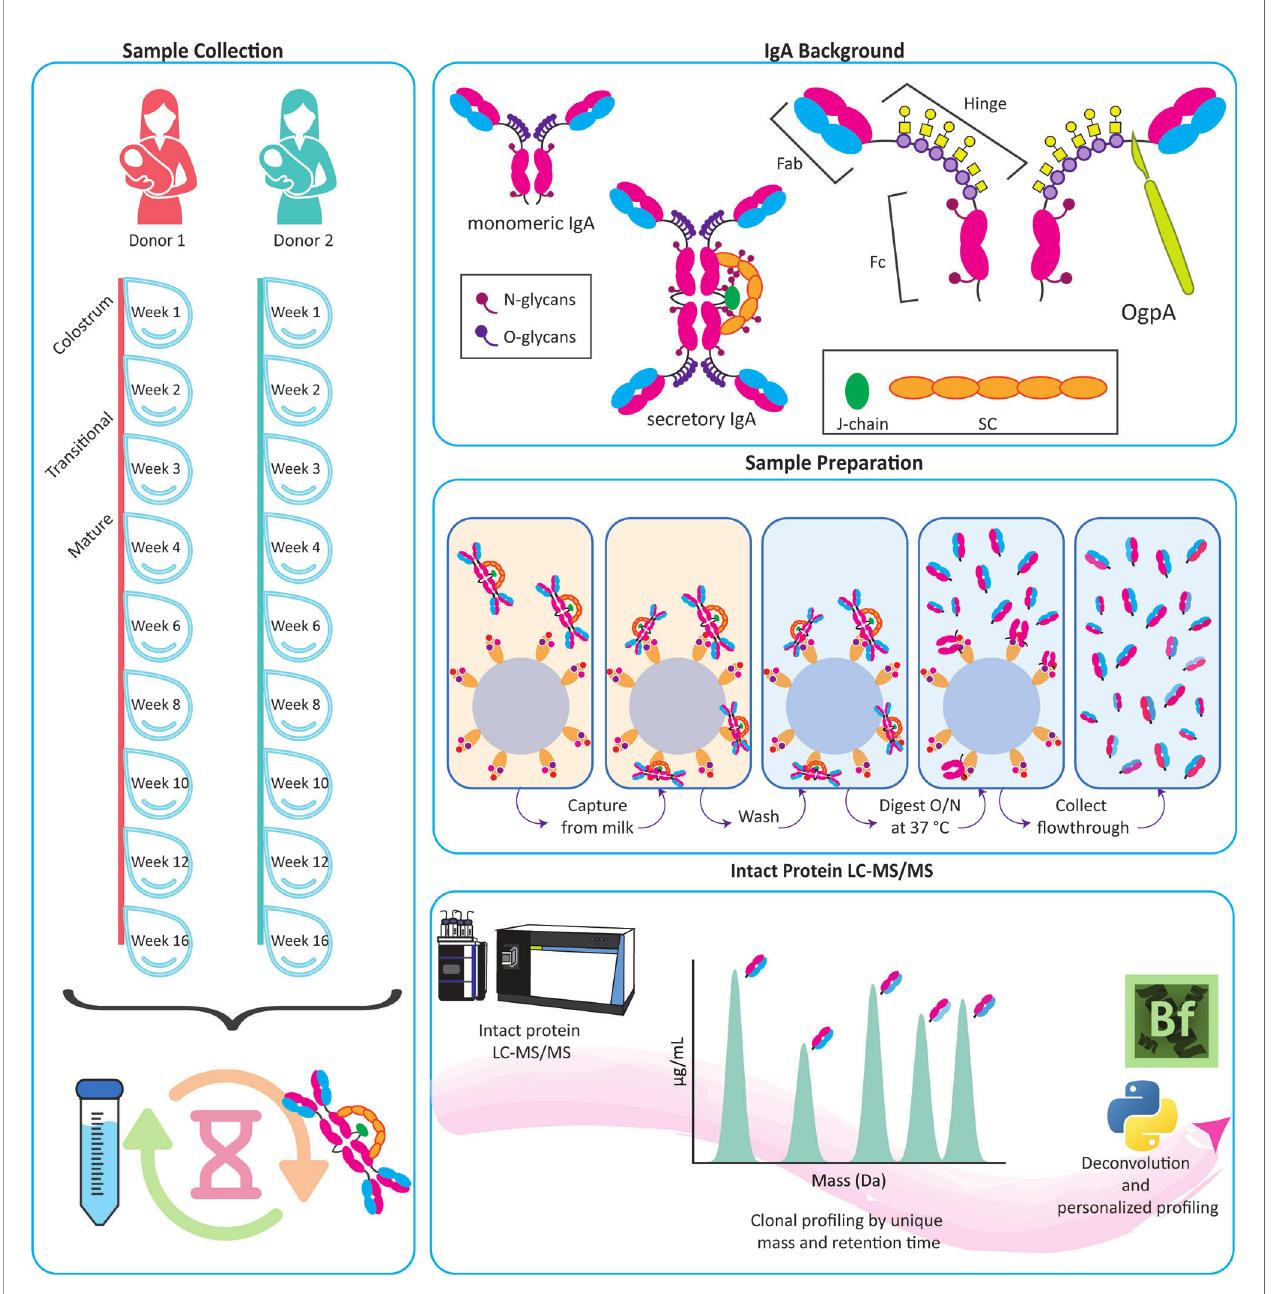
FIGURE 1 | Personalized human milk sIgA1 Fab clonal pro fi ling. Longitudinal human milk samples were obtained, with consent, from two healthy donors across weeks 1-16 of lactation (left panel). Following ef fi cient capture of sIgA1, using CaptureSelect IgA af fi nity matrix beads, we relied on the O- glycopeptidase from Akkermansia muciniphila (OgpA), cleaving N-terminally of the O -glycans that are exclusively present in the IgA1 ’ s hinge region (top panel), to dissect and collect their Fab fragments. The protocol works equally well, for capture and digestion, for human milk sIgA1 and plasma-derived or recombinant monomeric IgA1 (middle panel). The eluted Fab molecules were subsequently mass analyzed by reversed phase LC-MS, and masses were retrieved from the generated RAW fi les using BioPharmaFinder with additional data analysis performed using Python (bottom